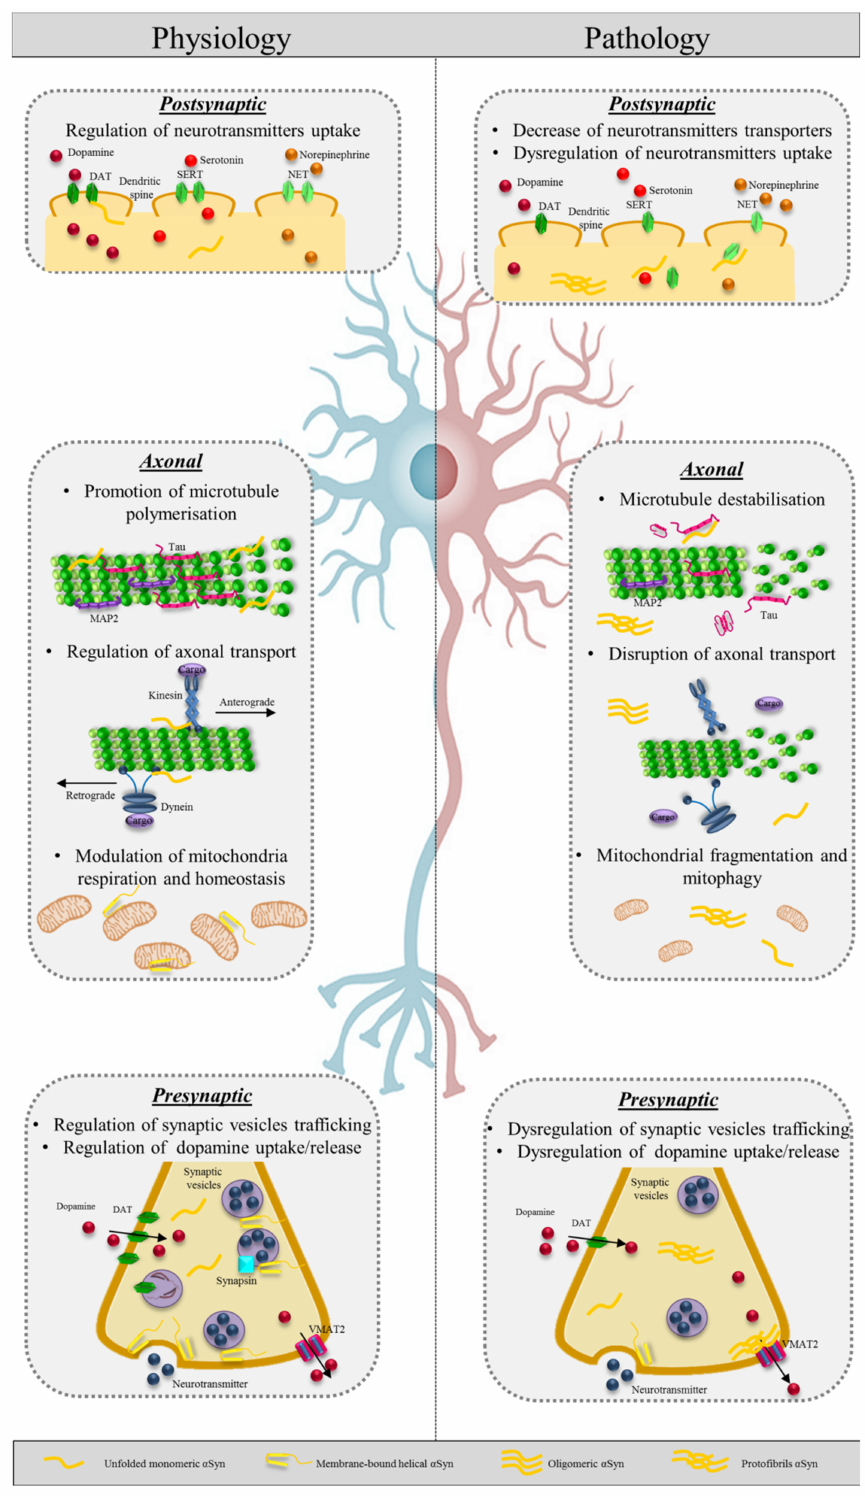
Figure 3. α Syn protein in physiology and pathology. On the left, schematic representation of physiological α Syn functions at the postsynaptic, axonal, and presynaptic level. On the right, the pathological e ff ects of abnormal (oligomeric and protofibrillary) α Syn in the three cellular compartments. SERT:serotonin; NET: norepinephrine; DAT: dopamine transporter; VMAT2: vesicular monoamine transporter